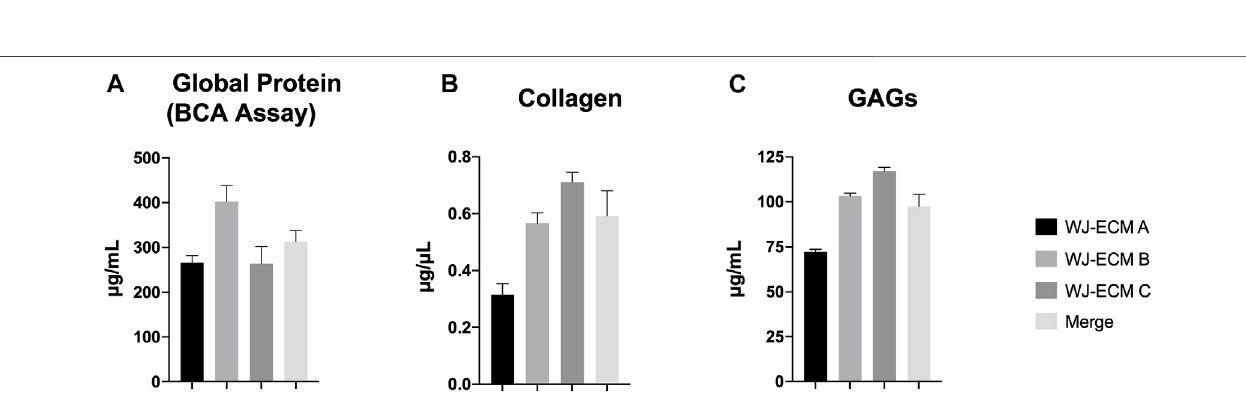
FIGURE 1 | Evaluation of the decellularization ef fi ciency of WJ-ECMaa. (A) DNA quanti fi cation in native WJ and decellularized WJ-ECMaa. Results represent the mean of three different assays. (B) Nucleic acid migration pro fi le for the three native WJ and their respective decellularized WJ-ECMaa. Results are presented as the mean ± SEM for each condition, and statistically analyzed following an unpaired t-test ( p -value: *** < 0.001); n = 3.